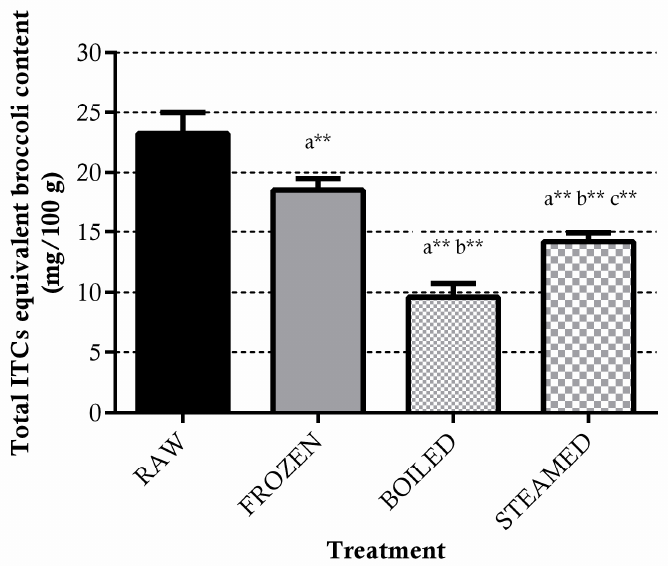
Figure 1. Total ITCs equivalent levels in raw, frozen ( − 20 ◦ C for 15 days) boiled and steamed broccoli. All samples were incubated with myrosinase at 60 ◦ C for 2 h to promote the hydrolysis of GLSs to ITCs. Data are expressed as mg/100 g of fresh vegetable ± SD of five cooking replicates. ** p < 0.01 vs. raw (a), frozen (b) and boiled (c).